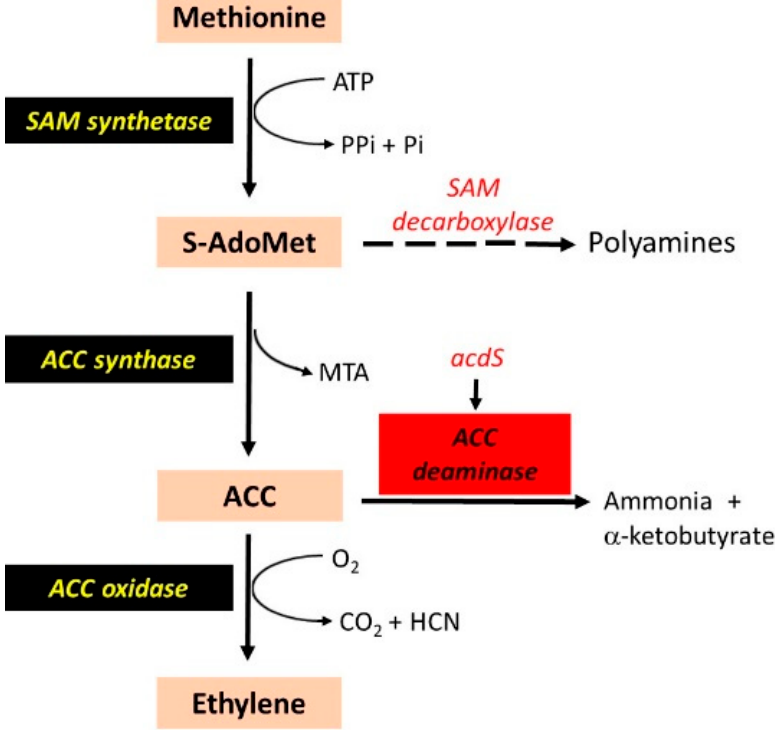
Figure 1. Pathway of ethylene synthesis and reduction in its level through substrate mobilization. S-AdoMet or SAM, S-adenosylmethionine; MTA, Methylthioadenosine; ACC, 1-aminocyclopropane-1-carboxylic acid.